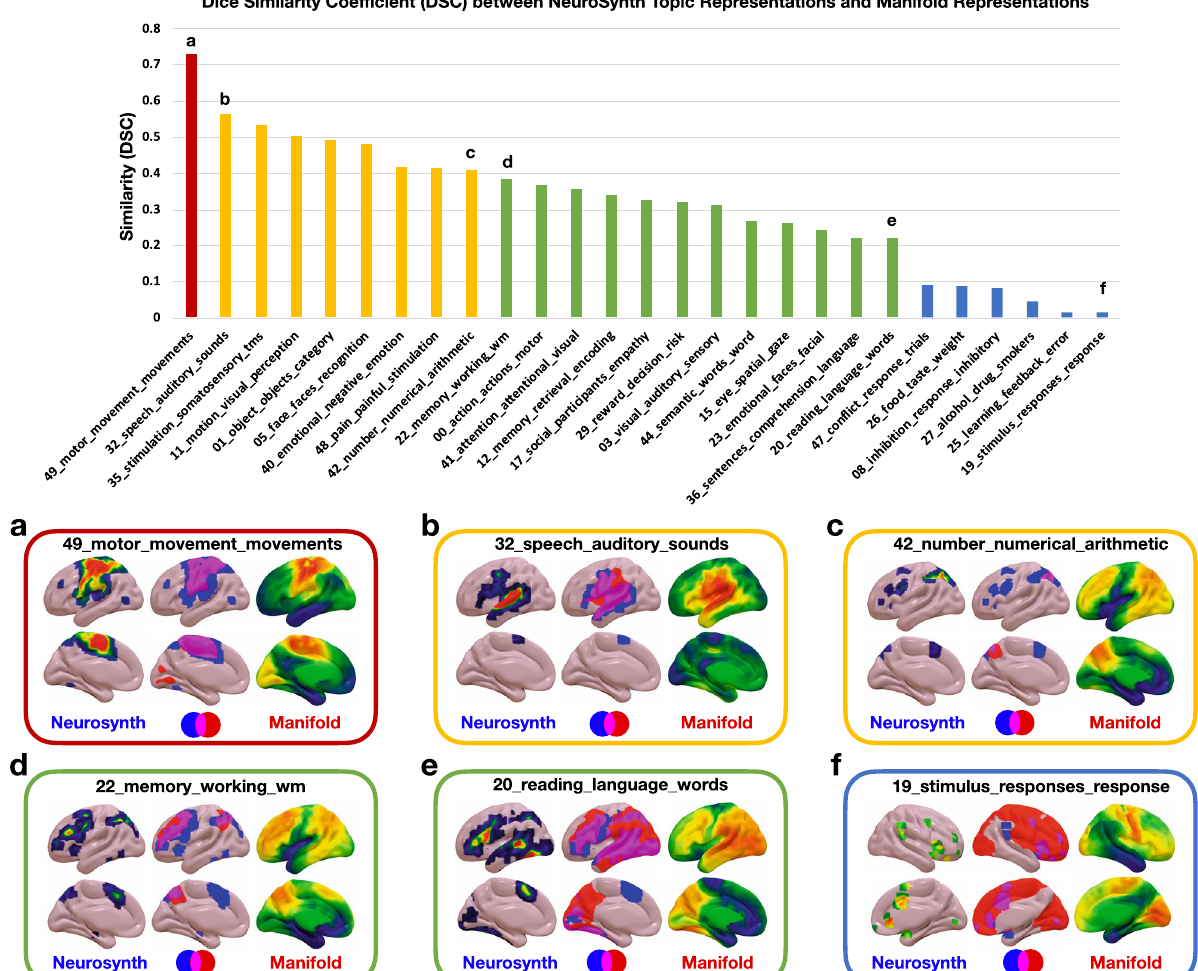
Fig. 6 Similarity between eigenbrain representations and Neurosynth topic representations. Top, bar graph of the Dice similarity coef fi cient (DSC) between Neurosynth topic maps and thresholded manifold representation of topic maps order from highest to lowest DSC and colored into four similarity categories: 0-0.2 poor (blue), 0.2 – 0.4 fair (green), 0.4 – 0.6 moderate (yellow), 0.6 – 0.8 good (red). The letters a – f correspond to the visualization of the spatial overlap represented on surfaces below the bar graph. a – f , The thresholded Neurosynth anatomic representations, the manifold anatomic representations, and the overlap of the binarized representations (blue = Neurosynth, red = manifold, pink = overlap) are displayed on brain surfaces for these six topic terms. Source data are provided as a Source Data fi